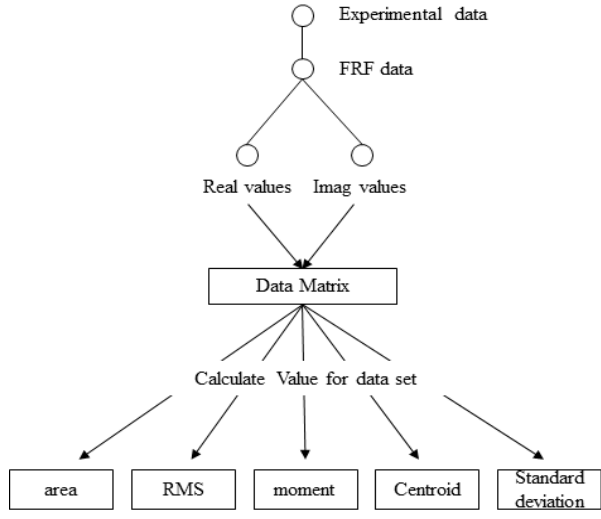
Figure 12. Features extracted from frequency response of experimental data.